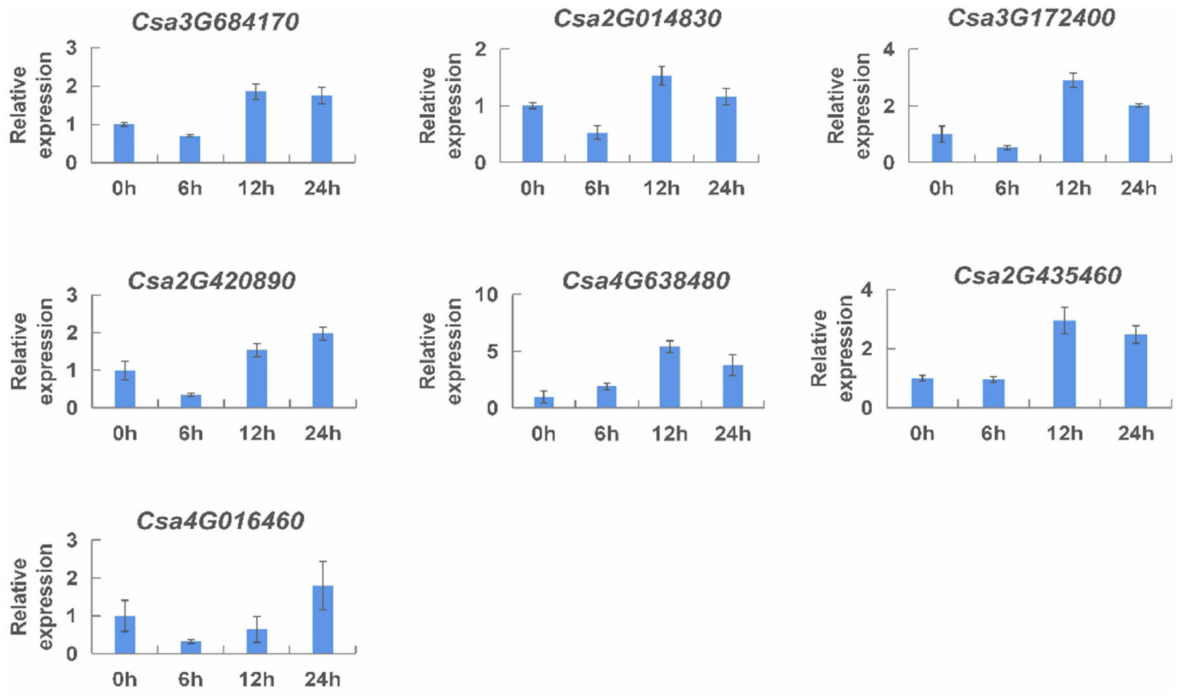
Figure 9. Expression analysis of the CNL genes responding to ethylene treatment in cucumber plants. The vertical axis is relative expression level and 0, 6, 12, 24 h on the x -axis indicate the treatment time. The expression level of transcript at 0 h was set to a value of ‘1’. Values are mean ± SE (n = 3).